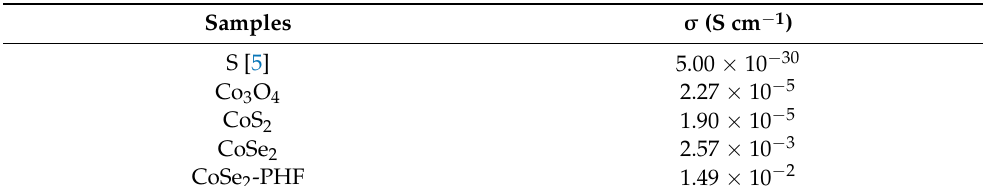
Table 2. Electrical conductivity of different samples.